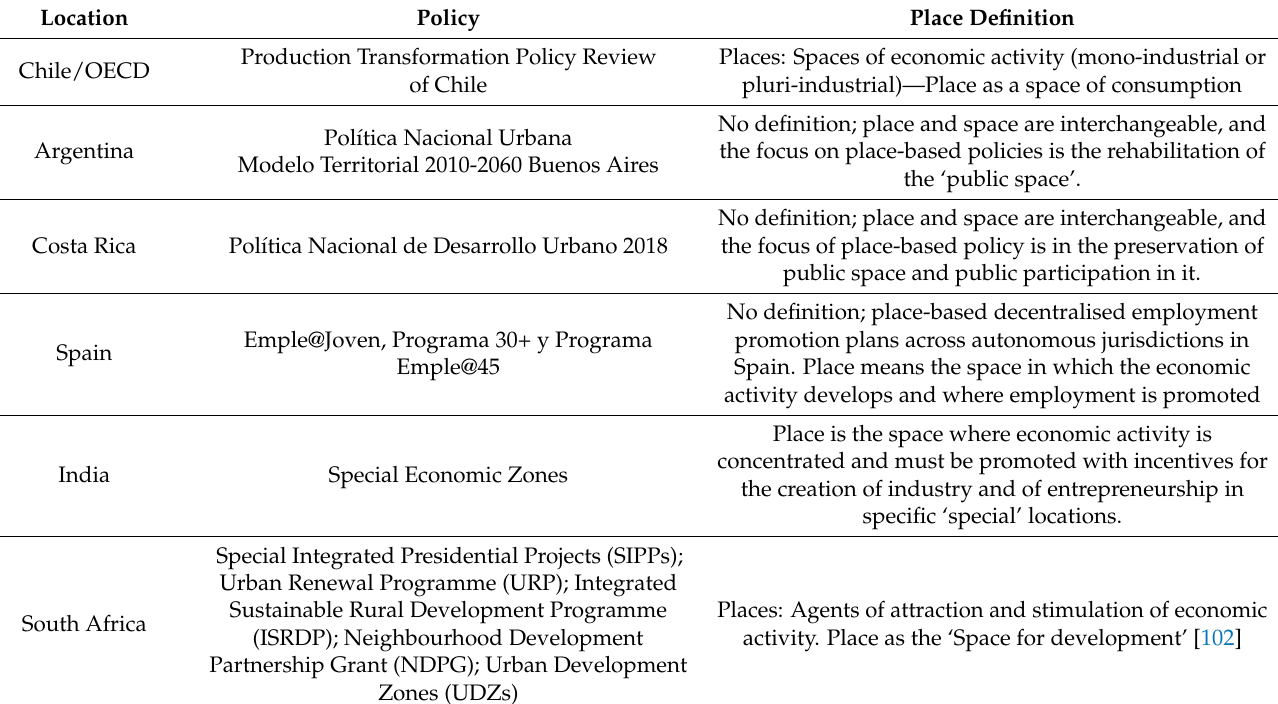
Table 2. A few Global South “place-based” policies and their understanding of